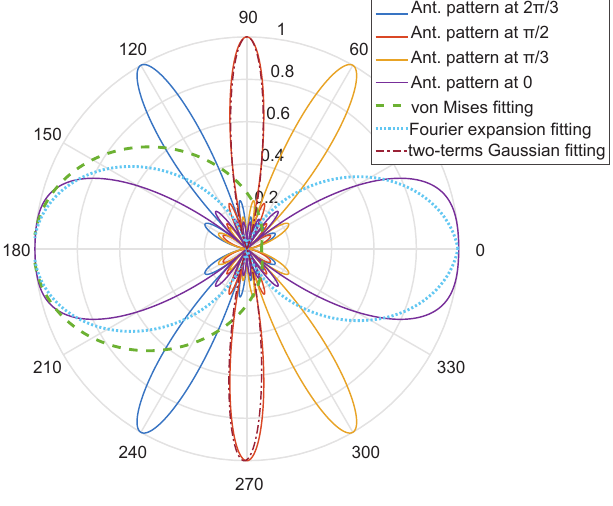
Figure 4. Fitting of beam radiation